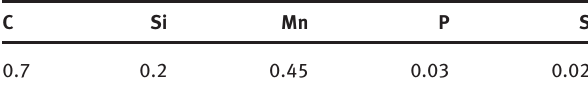
Table 4: Nominal chemical composition of the matrix steel (wt%).